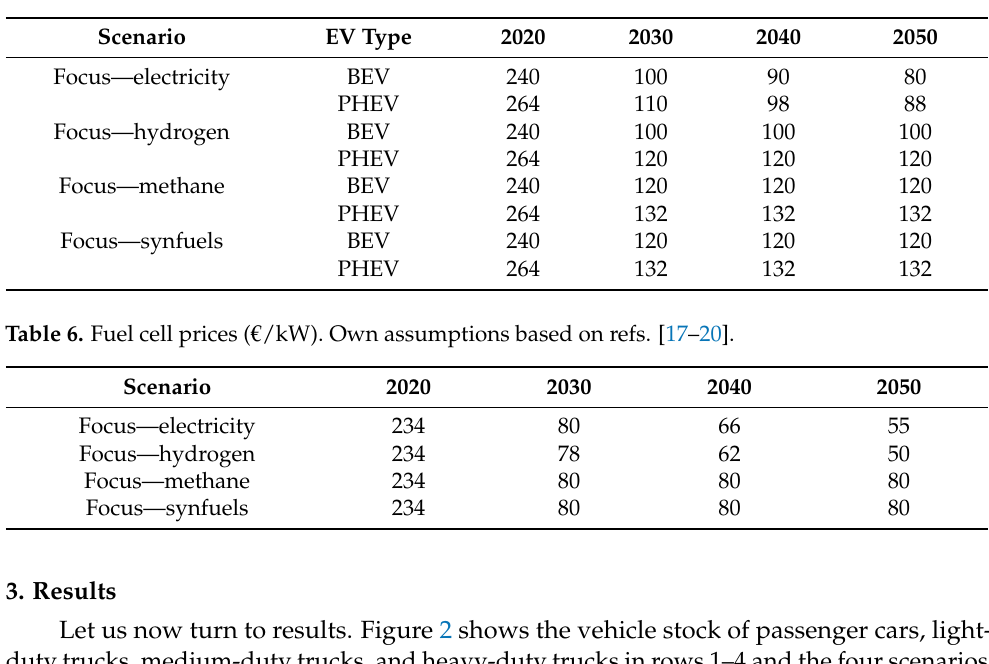
Table 5. Battery prices ( € /kWh). Own assumptions based on refs. [17,18].